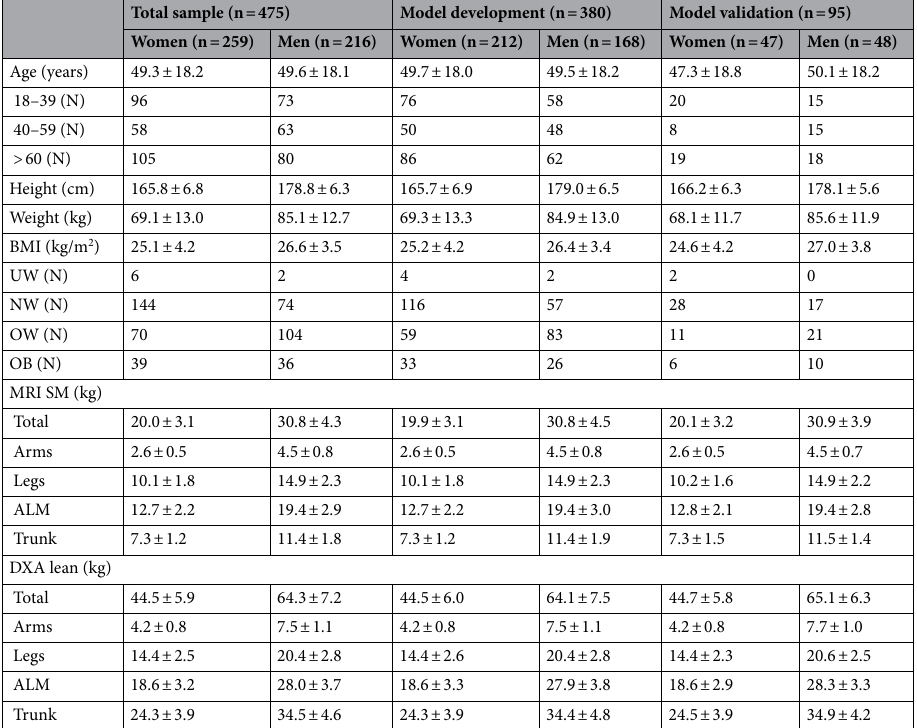
Table 1. Participant Characteristics (X ± SD). ALM appendicular lean mass, BMI body mass index, DXA dual- energy X-ray absorptiometry, MRI magnetic resonance imaging, N number, SM skeletal muscle, UW, NW, OW, OB are underweight (BMI, < 18.5 kg/m 2 ), normal weight (18.5–24.9 kg/m 2 ), overweight (25.0–29.9 kg/m 2 ), and obese (> 30 kg/m 2